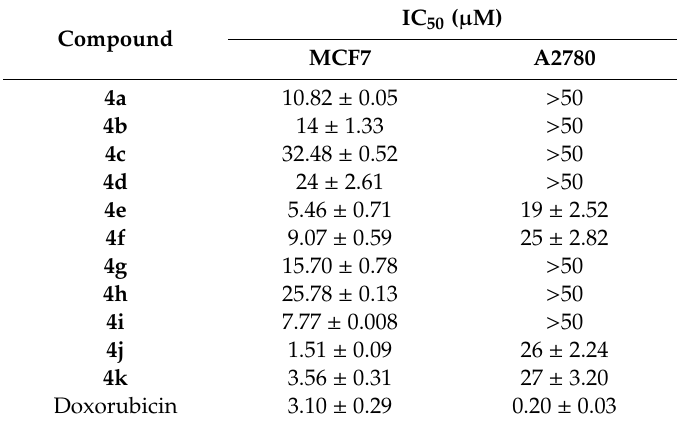
Table 1. Cytotoxicity of 4a – k against MCF7 and A2780 cell lines.